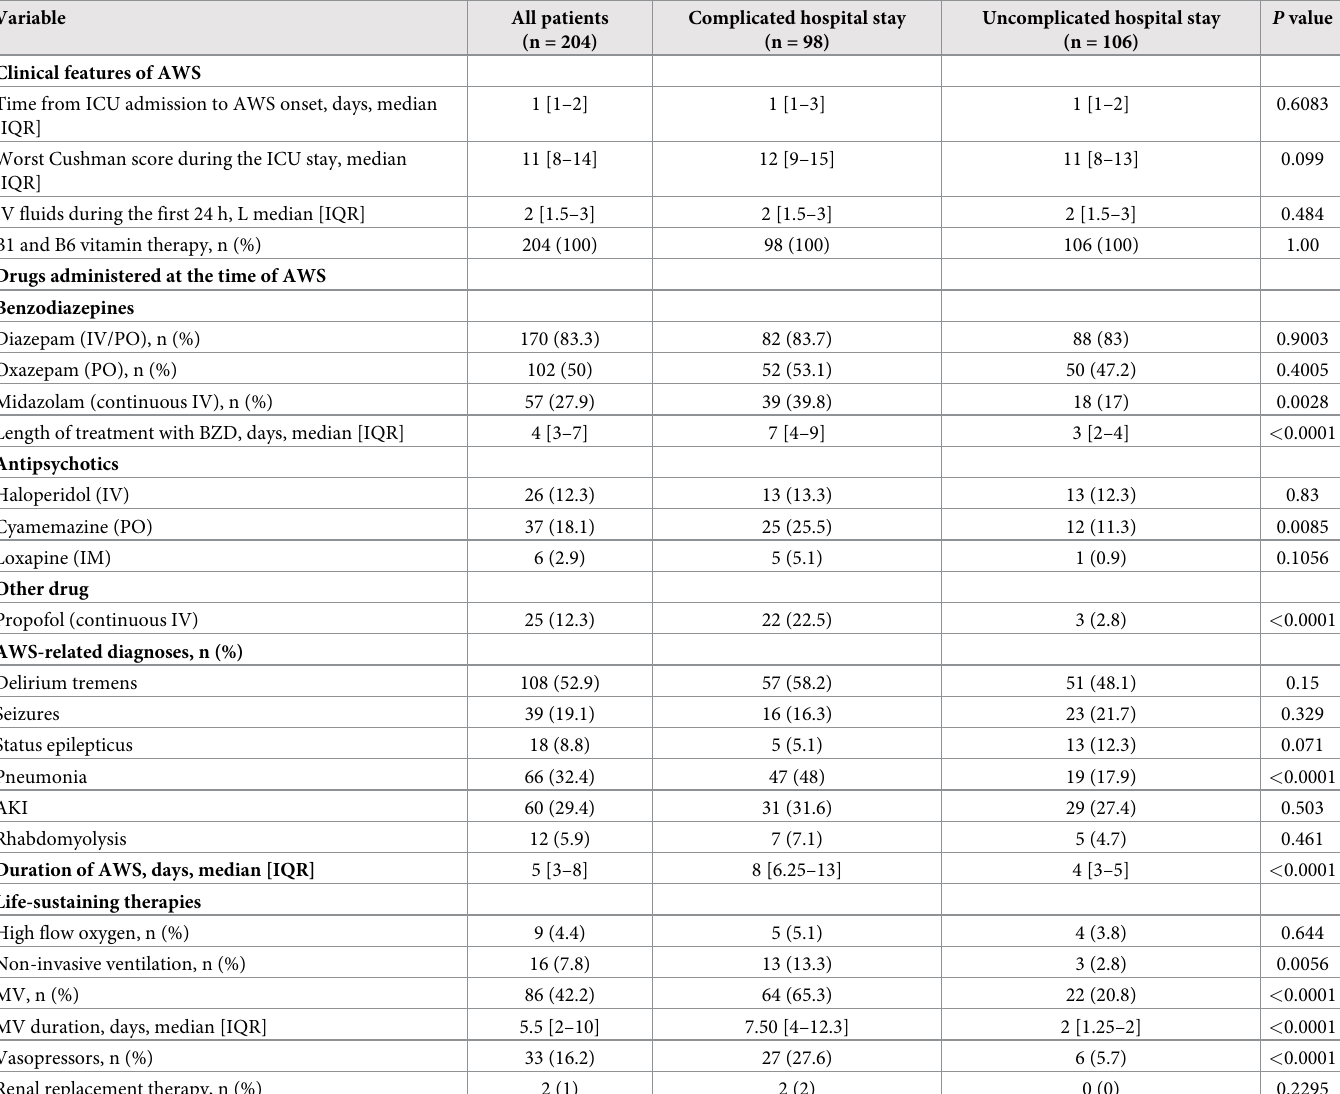
Table 2. Clinical features of AWS and pharmacological